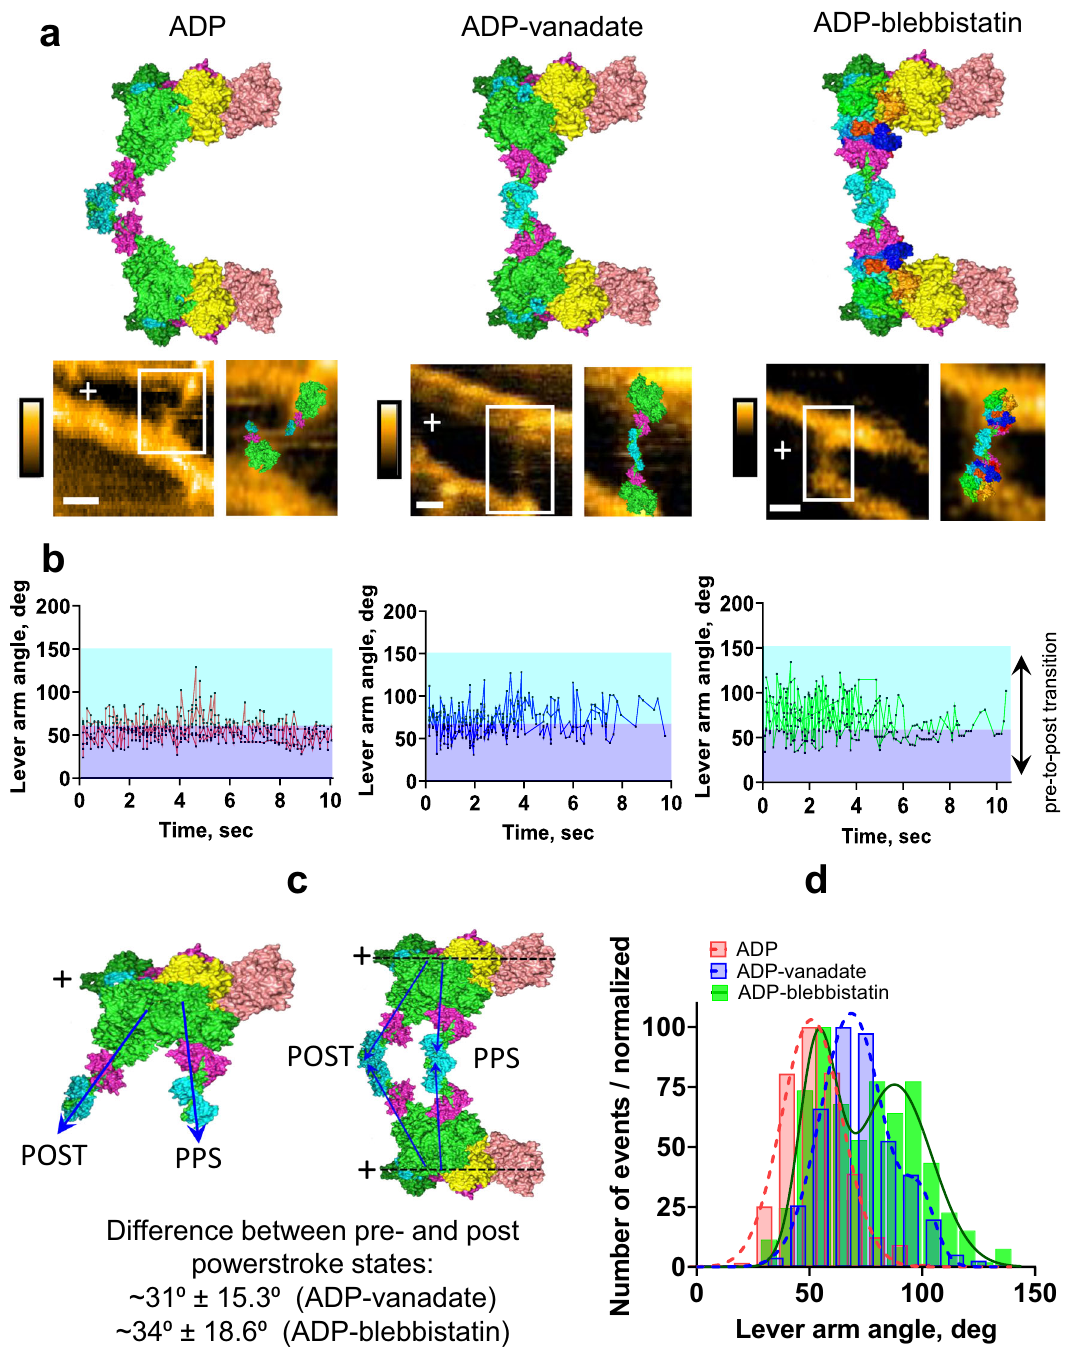
Fig. 6 | Myosin (HMM) molecules simultaneously attached to two different actin fi laments in the presence of ADP and either metavanadate or para- aminoblebbistatin. a Atomic models of myosin S1-ADP (PDB 3I5F), S1-ADP-VO 4 (PDB 1QVI), and S1-ADP-Blebbistatin (PDB 6Z7U with lever arm in pre-powerstroke con fi guration) and hs-AFM images of myosin heads simultaneously bound to two different actin fi laments in the presence of ADP, ADP-metavanadate and ADP-para- aminoblebbistatin(PAB);scalebars:30nm. b Leverarmanglesplottedasadynamic changeofleverarmcon fi gurationcollectedfor10s.Timeresolution:150ms/frame (6.7fps). Red: F-actin-HMM-ADP (number of events: 439). Blue: F-actin-HMM-ADP- metavanadate (number of events: 272). Green: F-actin-HMM-ADP-PAB (number of events: 266). The border between purple and blue areas indicates the mean angle for the lever arm in the ADP con fi guration obtained from Gaussian distributions. c Molecularmodelsof the pre-powerstoke(PPS,presenceof ADP-metavanadate or